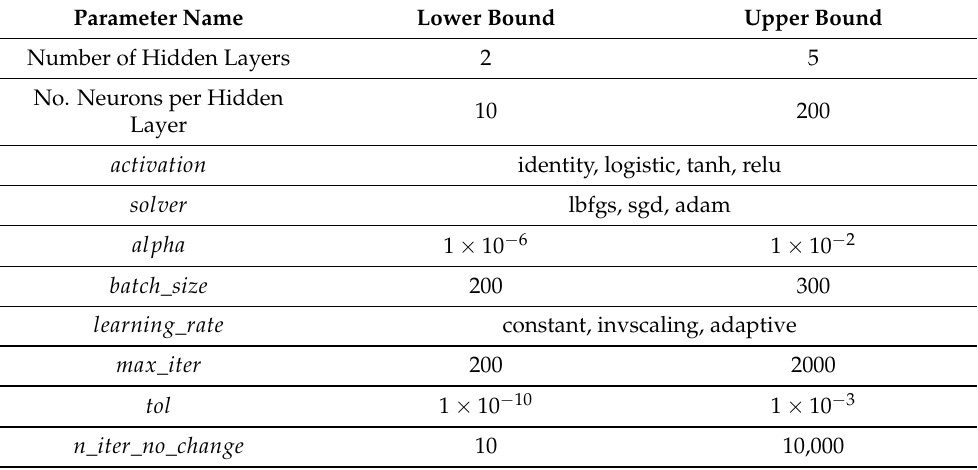
Table 10. An overview of the used hyper-parameters range for MLP Regression Algorithm.